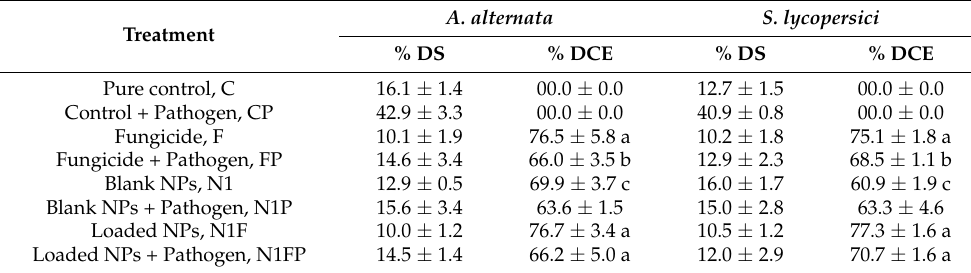
Table 4. Treatment effects of CSGA NPs on percentage disease severity (DS) and disease control efficacy (DCE) in tomato plants under pot house conditions against early blight and leaf